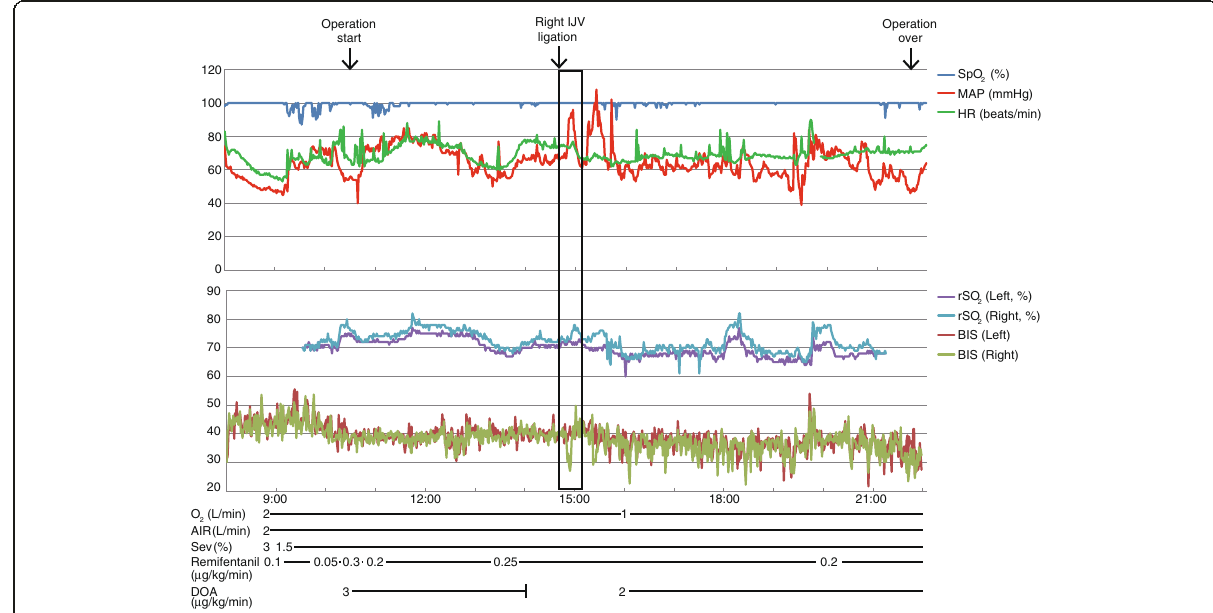
Fig. 1 Anesthesia record. Hemodynamic parameters, regional cerebral oxygen saturation (rSO 2 ), and the bispectral index (BIS) during general anesthesia are shown. SpO